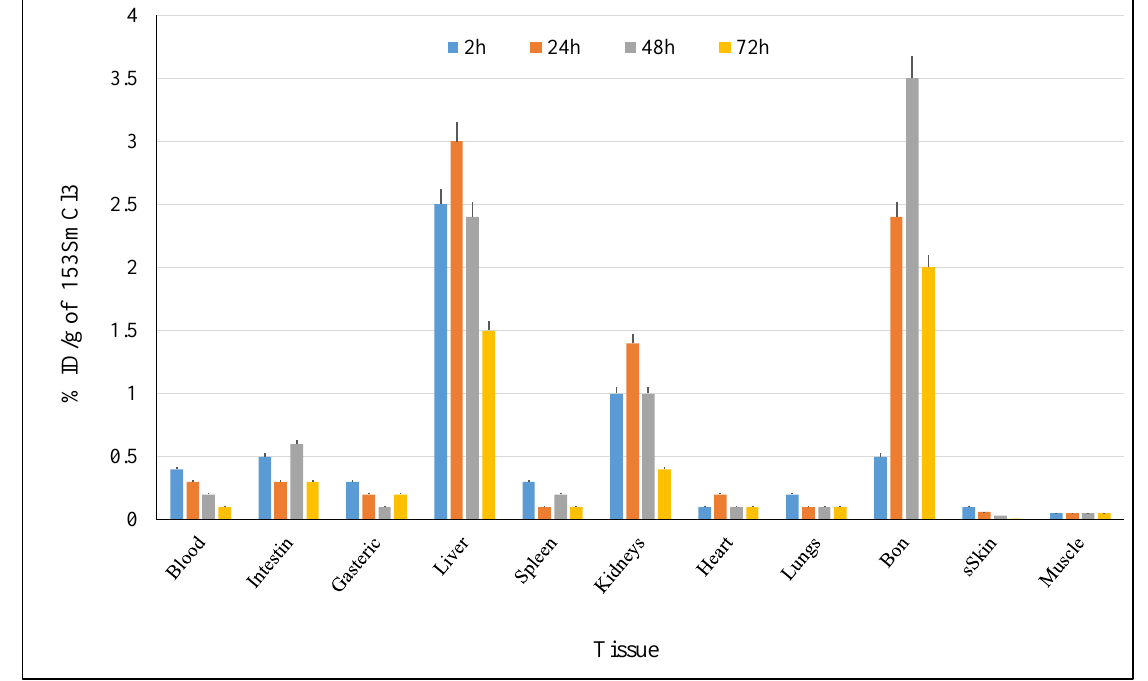
Figure 6A. Tissue distribution of 153 Sm activity in normal mice after injection of 153 SmCl 3 . Values are presented as percent